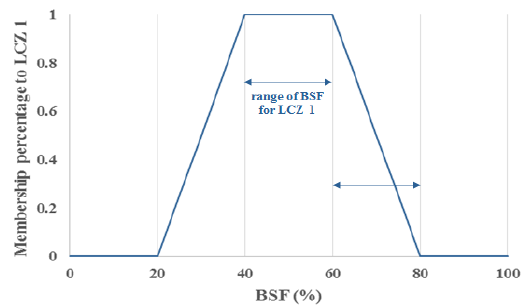
Figure 5. Linear fuzzy membership percentage given a range of value